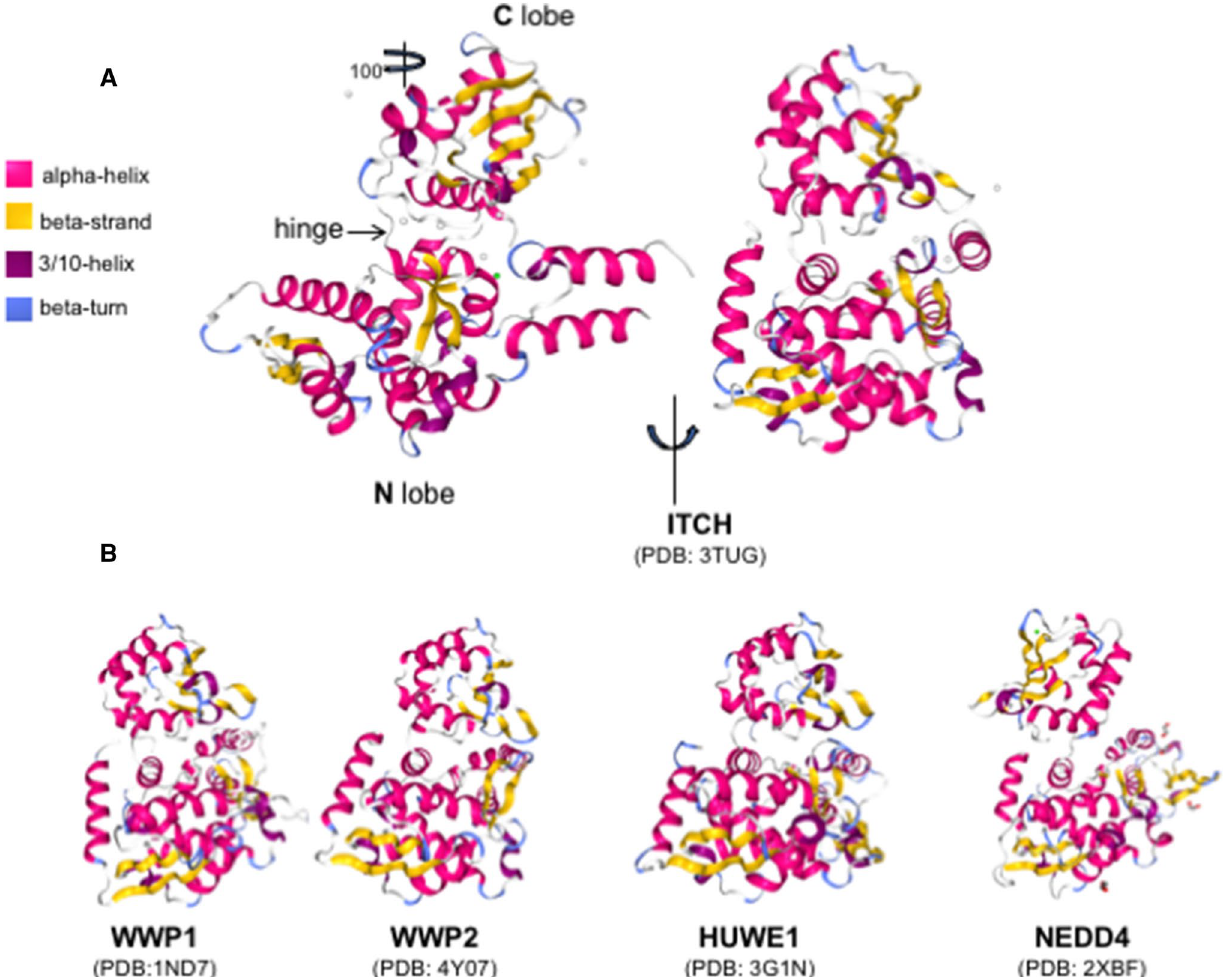
Fig. 1 A Structural models of ITCH (PDB: 3TUG) [114] showing the two lobes, with the hinge region in two orthogonal views. B Comparison of the HECT structure among different members of the sub-family, to highlight the high structural similarity between WWP1 (PDB: 1ND7) [33], WWP2 (PDB: 4Y07) [115], HUWE1 (PDB: 3G1N) [116], and NEDD4 (PDB: 2XBF)